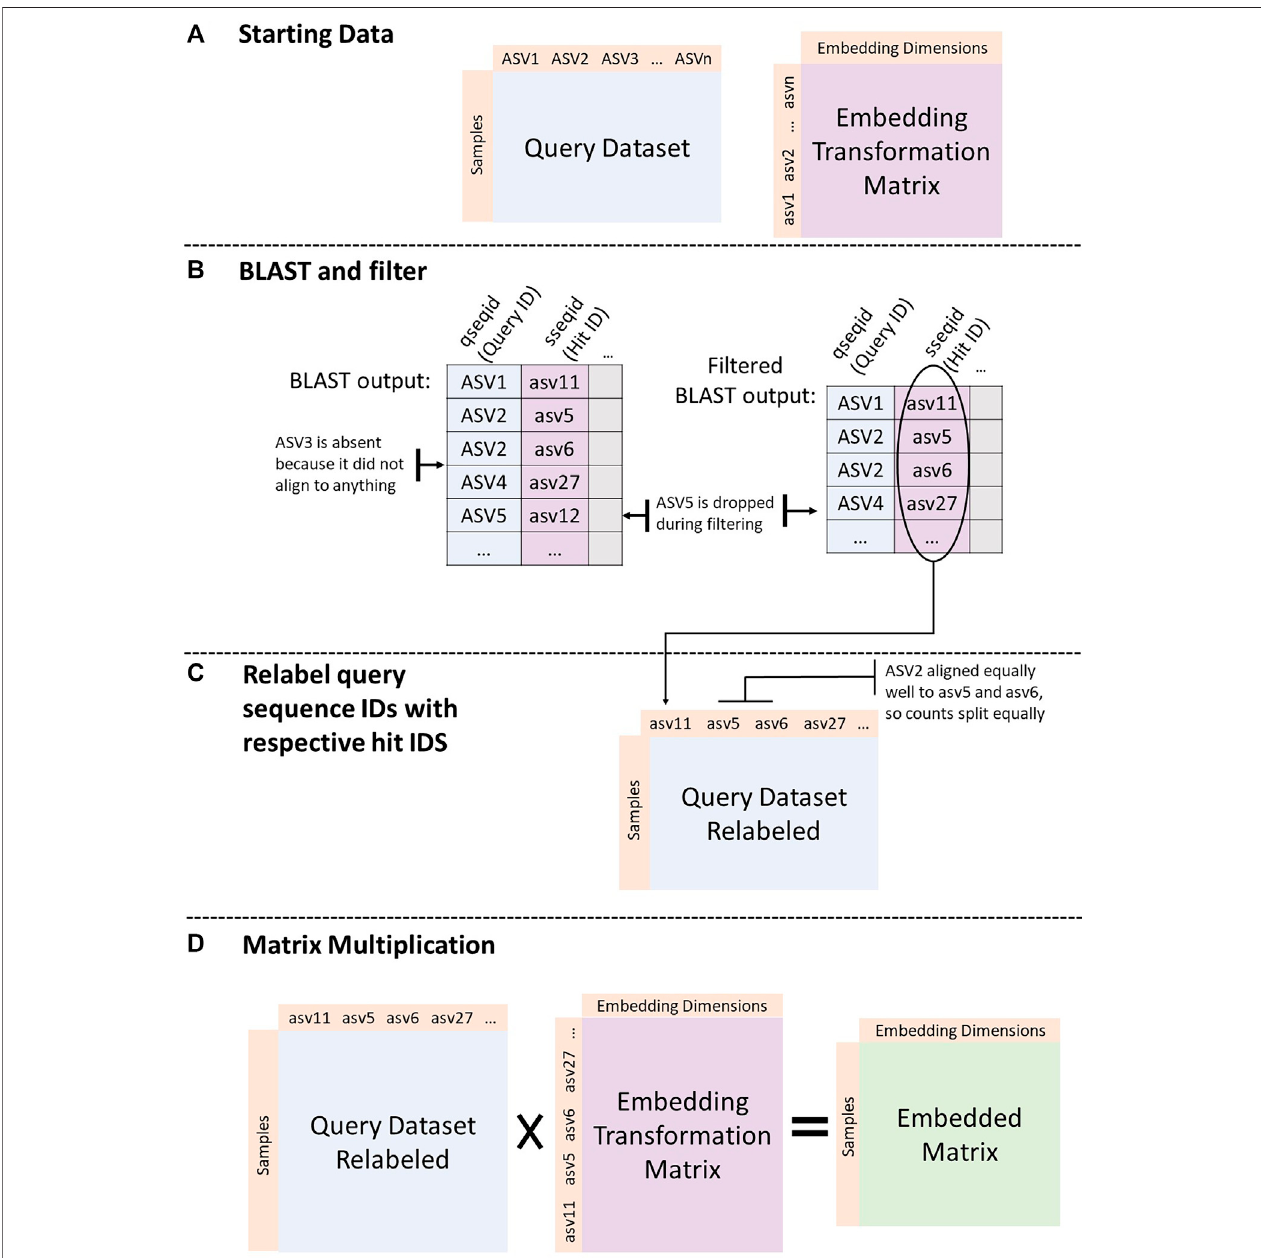
FIGURE1 | Embedding a dataset. (A) Start withquery dataset (sample by ASV counts) and an embedding transformation matrix (either from GloVe or PCA run on theAmericanGutProjectdata). (B) BLASTASVsequencesfromthequerydatasetagainstthesequencesinthetransformationmatrix.FiltertheBLASToutputtoinclude only top hits (min E-value, max percent identity, and max alignment length) per query sequence. (C) Assign ids from BLAST hit column to query sequences. If there are more than one best hit, split counts from original query sequence between all best hits equally. (D) Matrix multiply the query count table with the embedding transformation